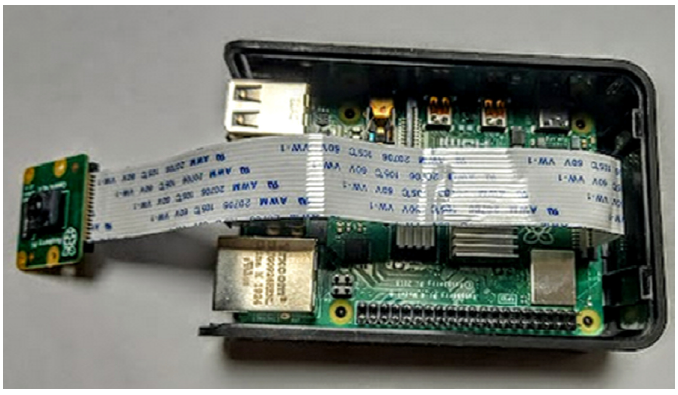
Figure 15. Proof of concept IIoT device.